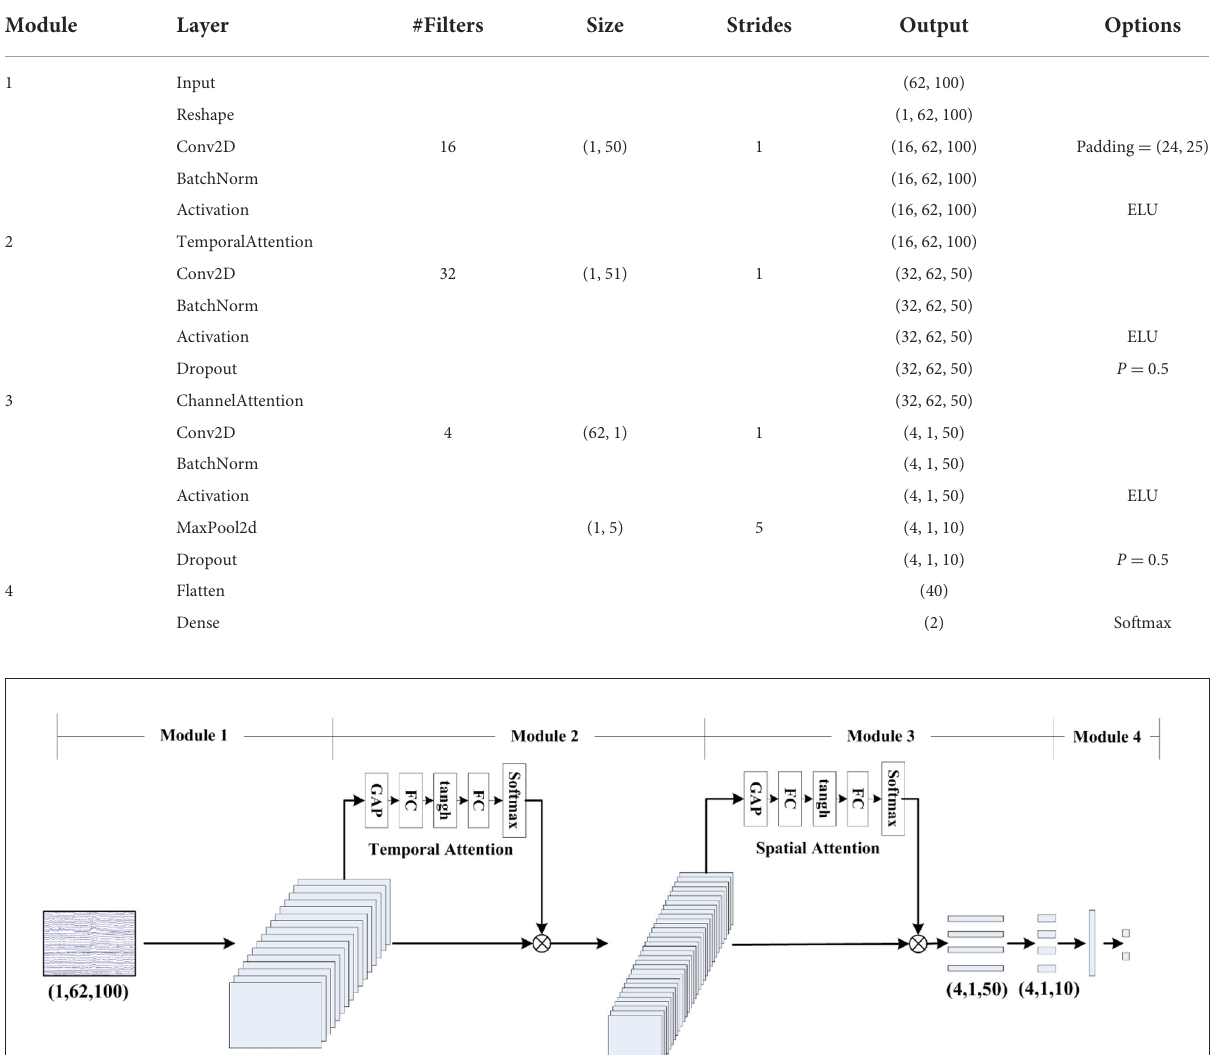
TABLE 1 Parameters setting of STA-CNN model.